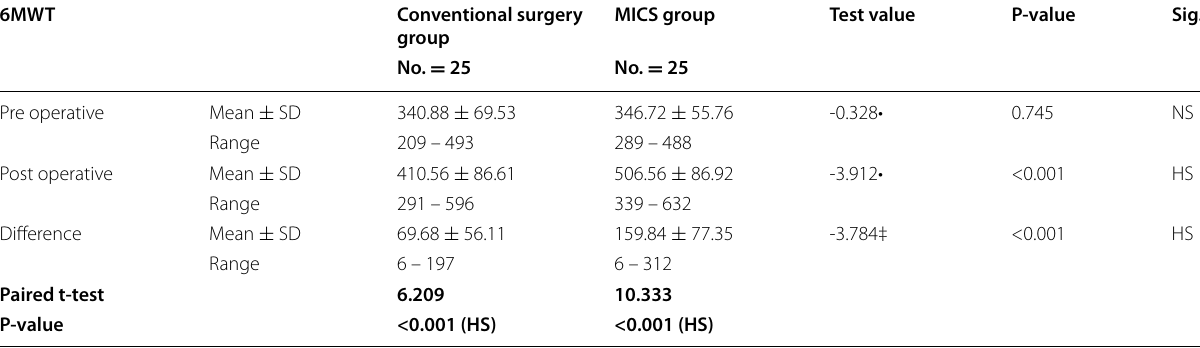
6MWT : Sex minute walking test, MICS group: Minimally invasive cardiac surgery group P is significant at